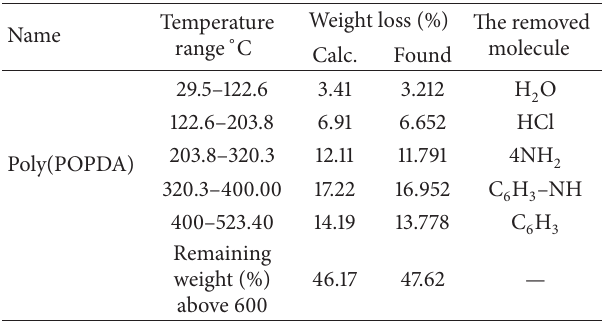
Table 4: Thermogravimetric data of poly-o-phenylenediamine